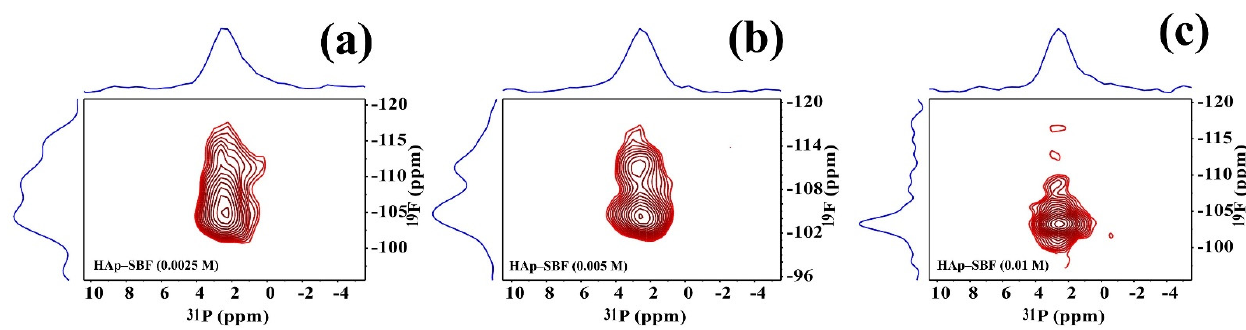
Figure 5. 1 H- 31 P 35 kHz HETCOR spectra of HAp synthesized in SBF and NaF solutions at different concentrations: 2.5 mM ( a ), 5 mM ( b ), and 10 mM ( c ).